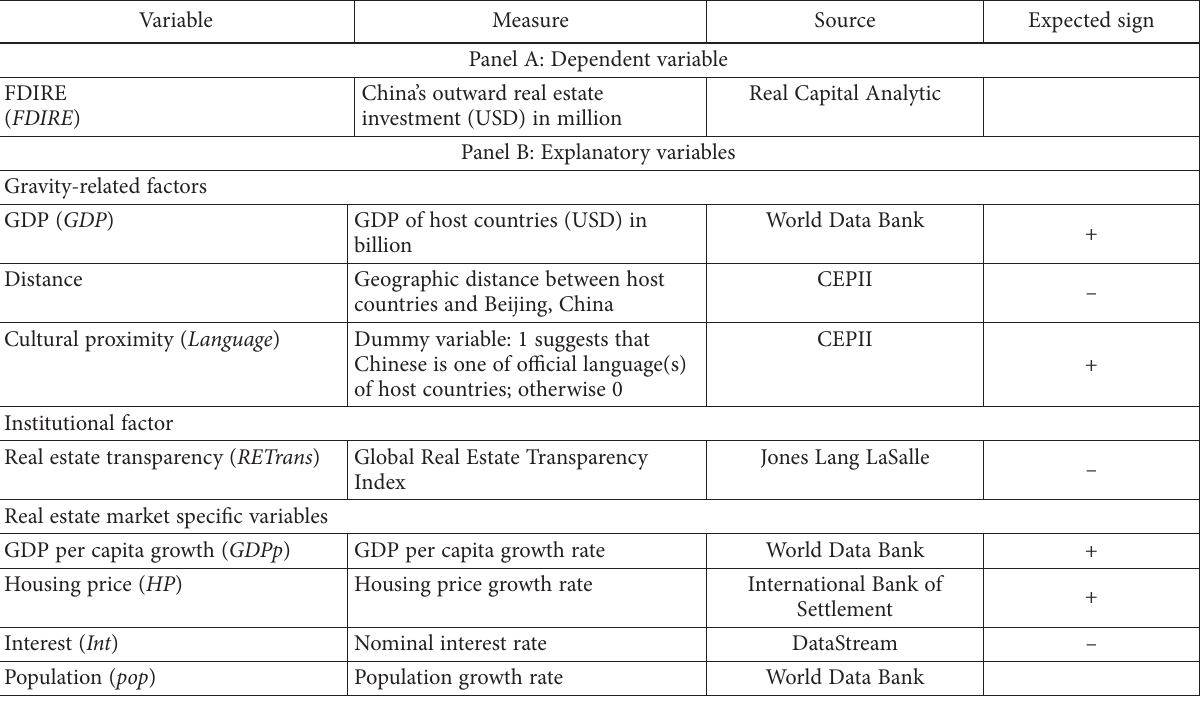
Table 1. Sources of